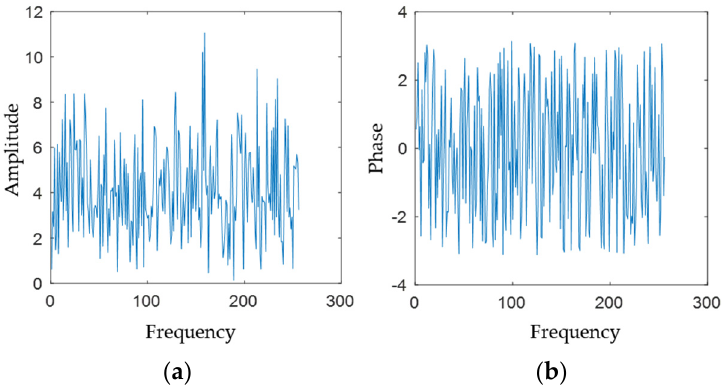
Figure 3. The diagrams of ( a ) amplitude and ( b ) phase of Gaussian white noise obtained by FFT.